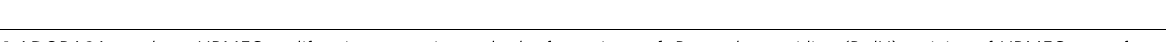
Fig. 4 ADORA2A regulates HRMEC proliferation, sprouting and tube formation. a , b Bromodeoxyuridine (BrdU) staining of HRMECs transfected with siRNAs targeting human ADORA2A (siA 2A R) or with a non-targeting negative control (siCtrl) under hypoxia conditions (0.5% O 2 ). n = 6. * P < 0.05. c Cell proliferation measured by WST-1 cell proliferation assay. n = 6. ** P < 0.01. d Growth curves of transfected cultures. n = 6. * P < 0.05, *** P < 0.001 vs. siCtrl. e – g Ki-67 and BrdU staining of HRMECs. HRMECs were infected with a recombinant adenovirus vector expressing human ADORA2A (Ad-A 2A R) or a negative control adenovirus (Ad-Ctrl) in the presence of adenosine. Scale bars : 50 μ m. n = 6. *** P < 0.001. h Cell proliferation measured by WST-1 cell proliferation assay. n = 6. *** P < 0.001. i Growth curves of HRMECs over 72 h following infection with Ad-Ctrl or Ad-A 2A R in the presence of adenosine. n = 6. *** P < 0.001 vs. Ad-Ctrl. j – u HRMECs were transfected with siA 2A R or siCtrl, or infected with Ad-Ctrl or Ad-A 2A R, and then were cultured in collagen gel to grow into 3D multicellular spheroids, or on a 2D matrix to form a tube network in the presence or absence of VEGF or adenosine. j , m Representative images of spheroidal sprouting after culturing for 24 h in collagen matrix under hypoxia (0.5% O 2 ) or normoxia (21% O 2 ). Scale bars : 100 μ m. Morphometric quanti fi cation of spheroid sprouting by calculating the number of sprouts per spheroid k , n as well as total sprout length l , o . n = 10 per group. n is number of spheroids quanti fi ed. ** P < 0.01; *** P < 0.001. Representative fl uorescence photographs of angiogenic tube formation p , s . Scale bars : 200 μ m. Cumulative tube length quanti fi ed using the Image J software q , t , and branch points calculated from fi ve experiments in